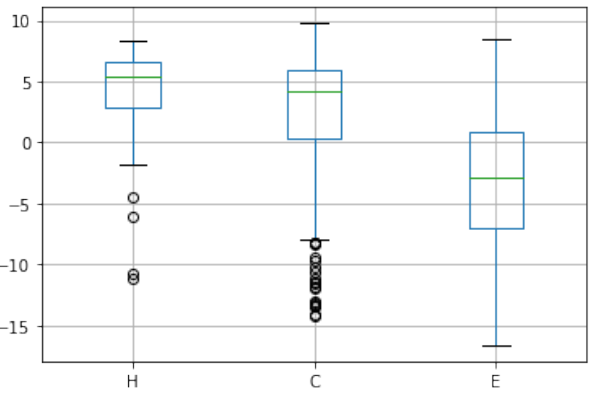
Figure 8. Box plots of the score distribution for each class: Healthy ( left ), Chronic ( center ), and Ex- trapyramidal ( right